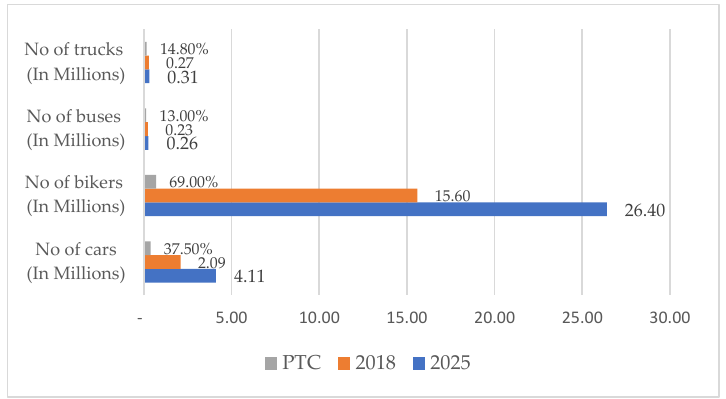
Figure 2. High growth in the transport sector, 2018 – 25 [11].